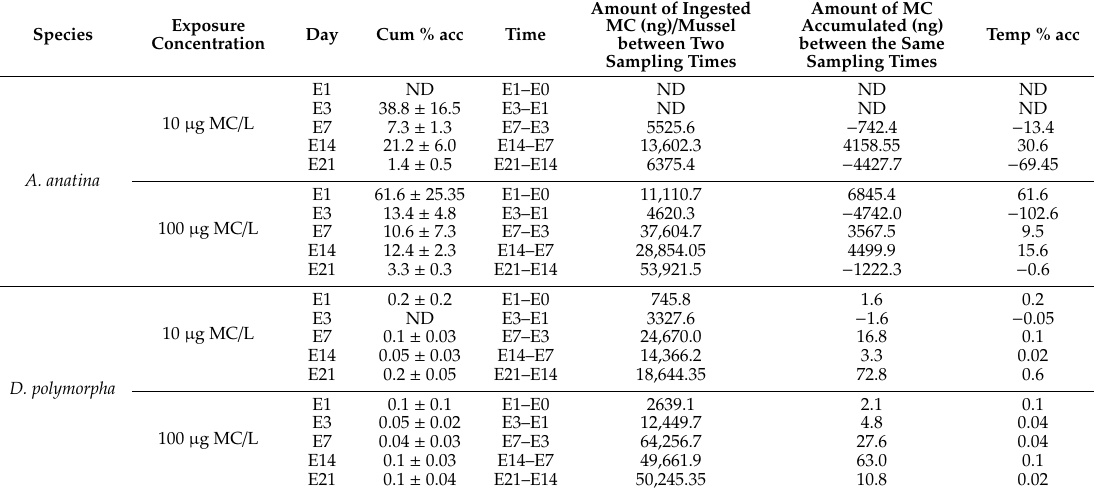
Table 2. Cumulated percentage of total MC accumulation (cum % acc), amount of ingested MC (ng) per mussel between two sampling times, di ff erence in the amount of total MC accumulated (ng) between the same sampling times, and temporary percentage of total MC accumulation (temp % acc) of the same time range. Data not shown due to technical di ffi culties are referred as ND (not determined). Species Exposure Concentration Day Cum % acc Time